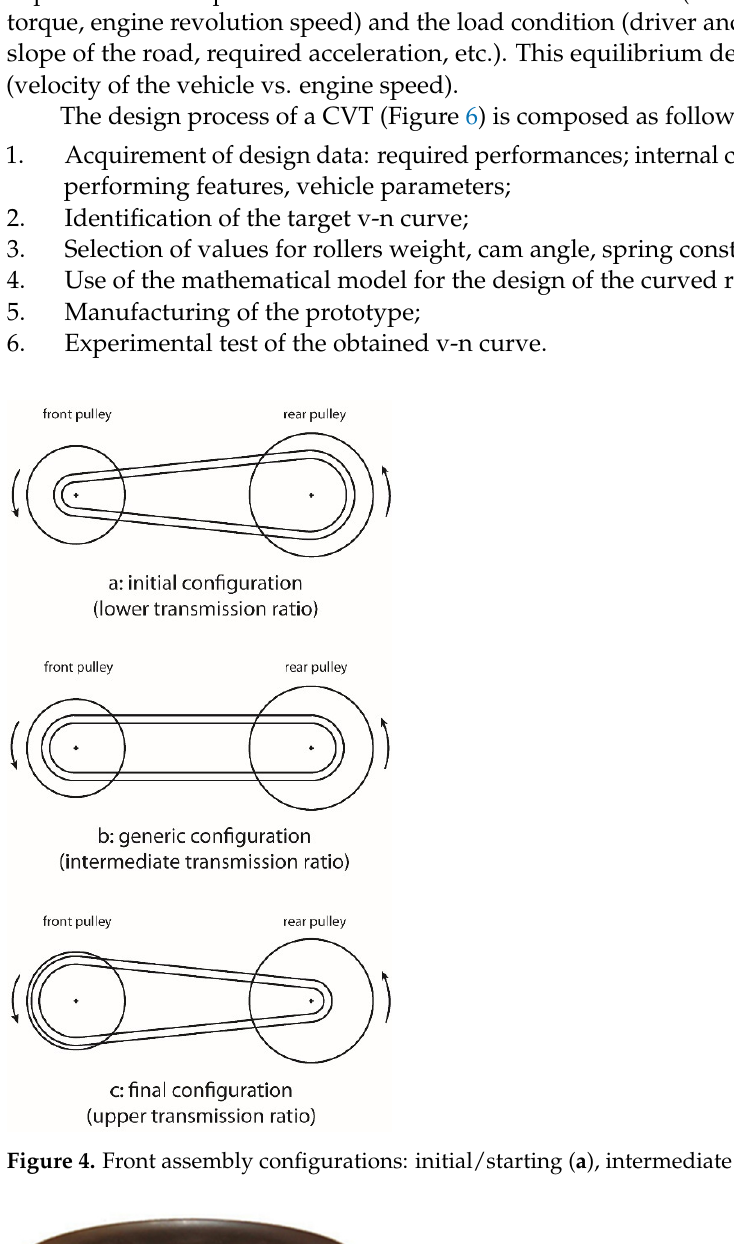
Figure 5. The driven actuator.